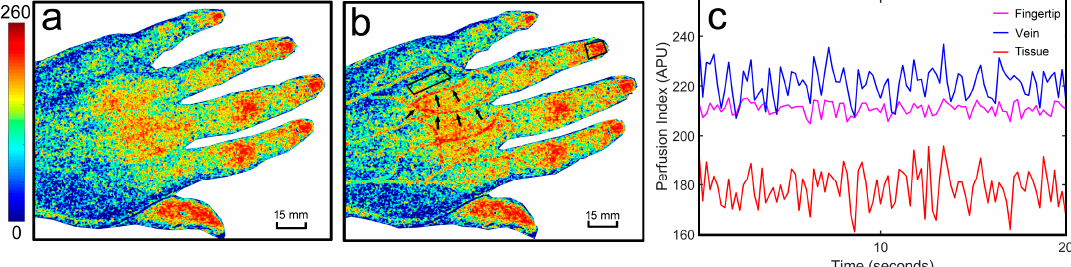
Figure 2. Example of superficial hand blood flow in one stroke patient. ( a ) A traditional LSCI image, which cannot reveal the vein vasculature details; ( b ) visible vascular information using dwLSCI and the ROIs we selected in the vein, its surrounding tissue and its supplying fingertip; ( c ) the perfusion index signals in the selected ROIs.